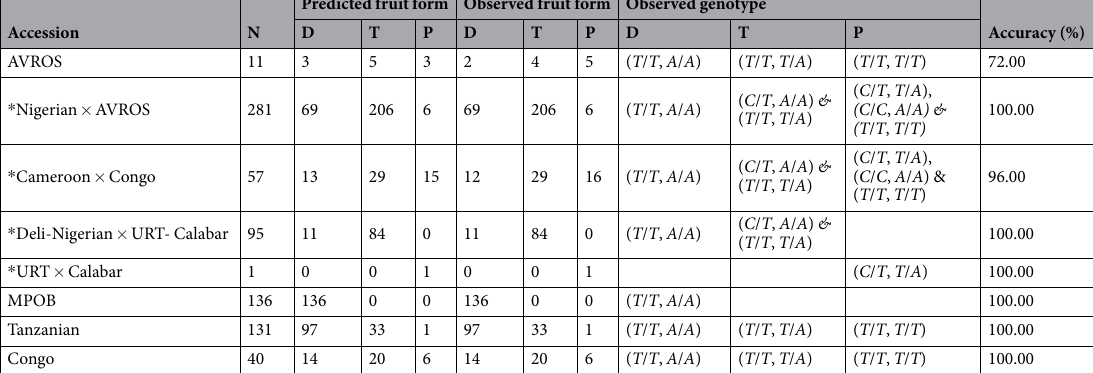
of a gene per diploid genome causing an inability to produce enough functional protein as wild-type dura palms in the cells; this leads to a haploinsufficiency of the heterodimer which mediates the effects of the SHELL gene. Hence, we scored the wild-type sh DeliDura / sh DeliDura which occurred at both M1 and M2 as two functional copies; one functional copy for a single mutation at either the M1 or M2 variant position per diploid; and nil functional copy for multiple mutations at both M1 and M2 positions. Next, we link the haploinsufficiency effect to the shell formation model through SHELL-SEP-like protein heterodimerization and DNA binding 4–6 (Fig. 3). The dura palms with two functional copies were not disrupted in shell formation at all, as expected. As for tenera , the two genotypes possible only contributed one functional copy of the SHELL protein, which explained the thinner shell